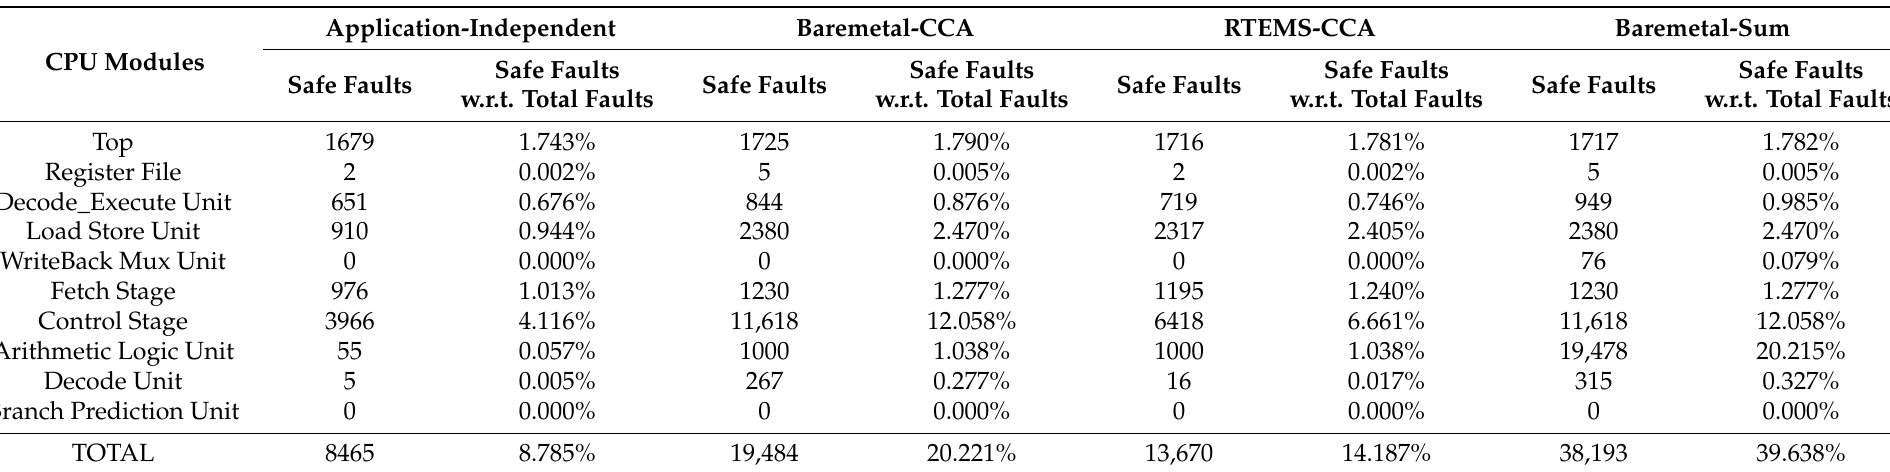
Table 2. Safe faults in